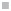
BAP accumulation in E. coli.E. coli treated with 250 μM (47 μg/mL) or 1250 μM (233 μg/mL) BAP in CAMHB (■) or M9-glucose (■) medium. Intracellular BAP accumulation was monitored by LC-MS (SRM method). BAP uptake is robust and dose-dependent in M9-glucose medium, and poor in CAMHB medium. (n = 3, error bars are standard error, p-values were calculated using an unpaired, 2-sample t-test).